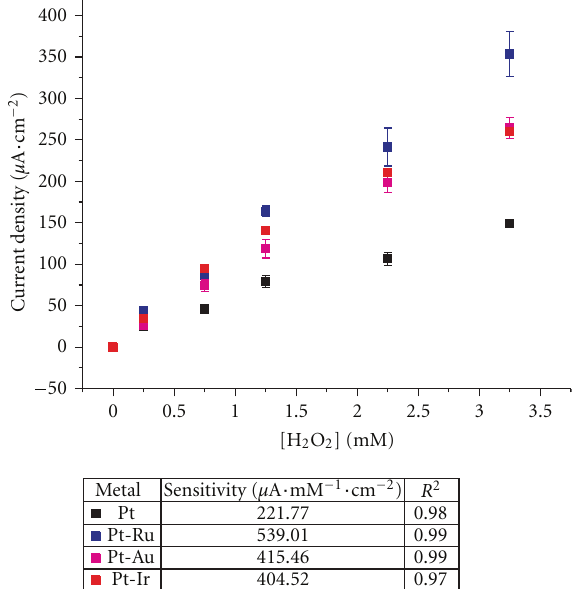
Figure 6: Current concentration of H 2 O 2 calibration plots at +0 . 25V versus Ag/AgCl.